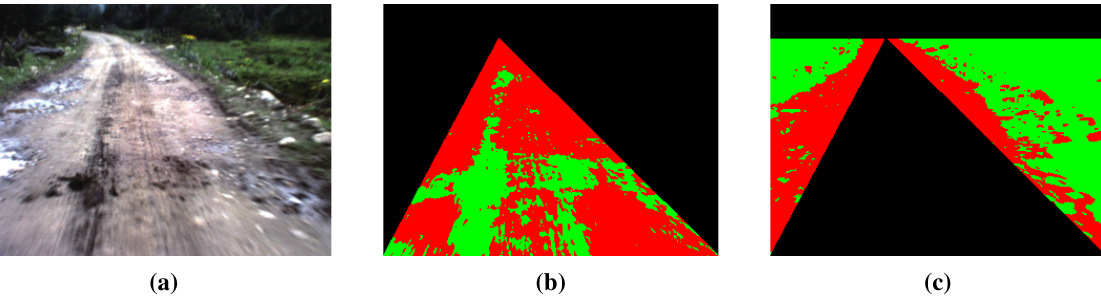
Figure 7. Road and background region clustering: ( a ) test road image; ( b ) road region clustering; ( c ) background region